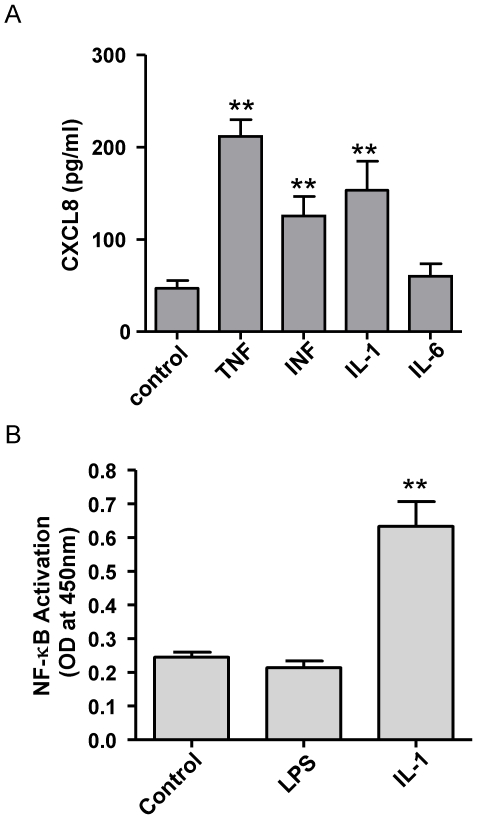
Activation of NFκB in undifferentiated hESC.(A), Undifferentiated H7 hESC were activated to release CXCL8 after 24 hours stimulation with TNFα (TNF), INFγ (INF) or IL-1β (IL-1) but not by IL-6 (10 ng/ml for each)(n = 6). (B), NFκB was activated in undifferentiated H7 hESC following 1 hour stimulation with IL-1β (1 ng/ml) but not by LPS (1 µg/ml) (n = 3). Statistical significance was calculated by one-way analysis of variance followed by Dunnett's Multiple Comparison Test (to control). **P<0.01.